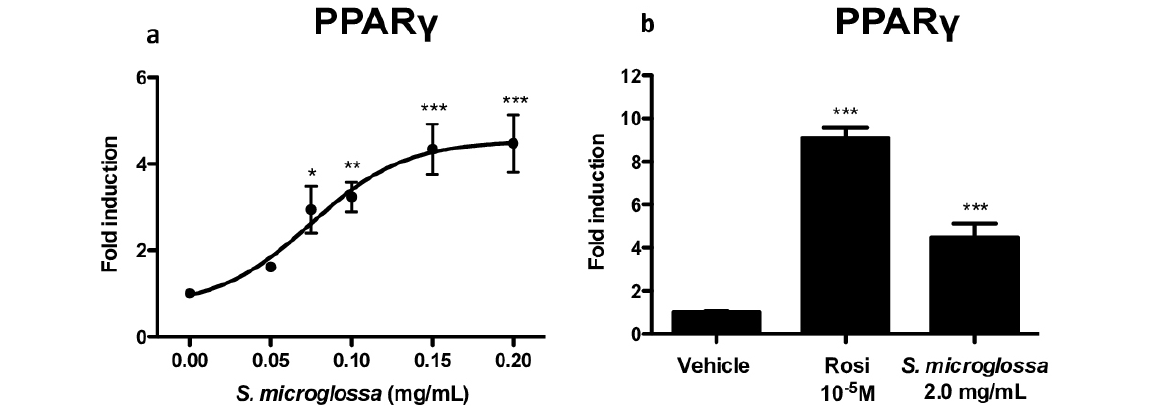
Figure 10. S. microglossa activates PPARγ. HeLa cells were cotransfected with plasmids containing the expression vector pCMV-SPORT6-PPARγ and the PPRE luciferase reporter and treated with vehicle (DMSO), rosiglitazone (Rosi) or increasing concentrations of S. Microglossa. S. microglossa activated PPARγ in a dose-dependent manner with an EC value of 0.75 mg/mL (a). The highest concentration of S. Microglossa (2.0 mg/mL) induced approximately 50 50% of the PPARγ activation promoted by rosiglitazone at 10 -5 M (b). The luciferase activity was measured after 24 h. * p ≤ 0.05, ** p ≤ 0.01, *** p ≤ 0.001 (compared to vehicle). Data are presented as the mean (SD) of three independent experiments conducted in triplicate. The statistical significance of the difference between the groups was assessed by one-way ANOVA followed by Tukey’s post hoc test. Values of p less than 0.05 were considered